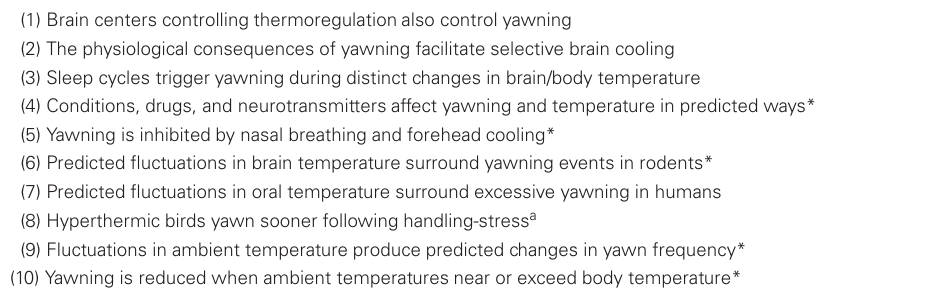
Table 4 | Summary of the association between yawning and